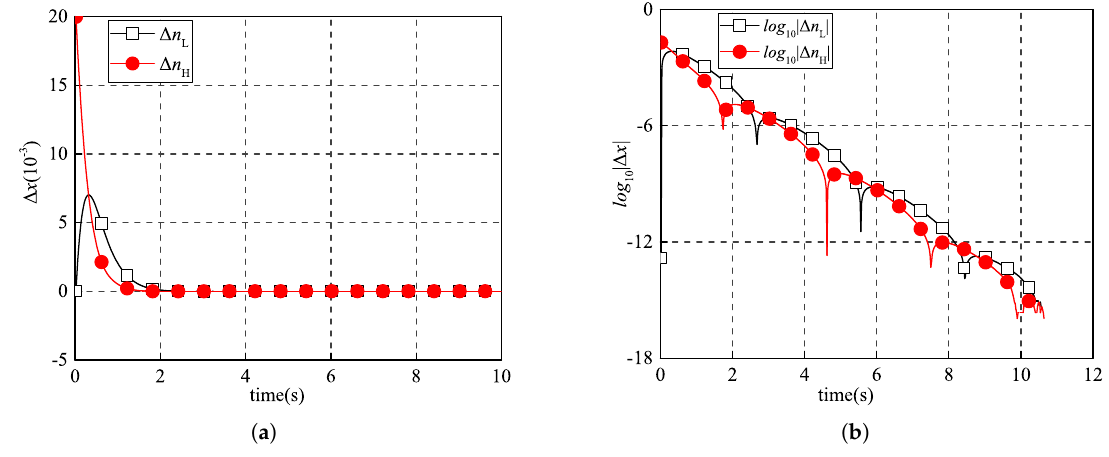
Figure 3. State response under a disturbance ∆ n H = 0.02. ( a ) conventional coordinate; ( b ) logarithmic coordinate.